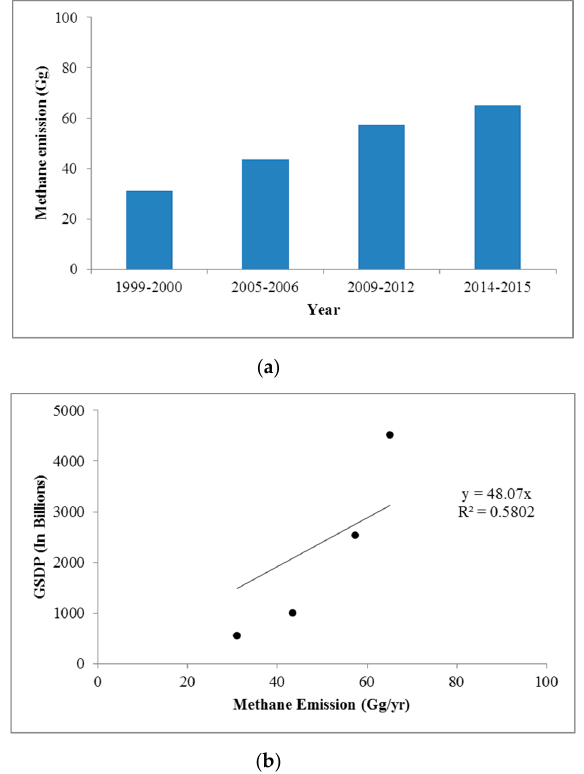
Figure 6. ( a ) Trend of CH 4 emission from landfill; ( b ) Correlation of the Gross State Domestic Product (GSDP) and CH 4